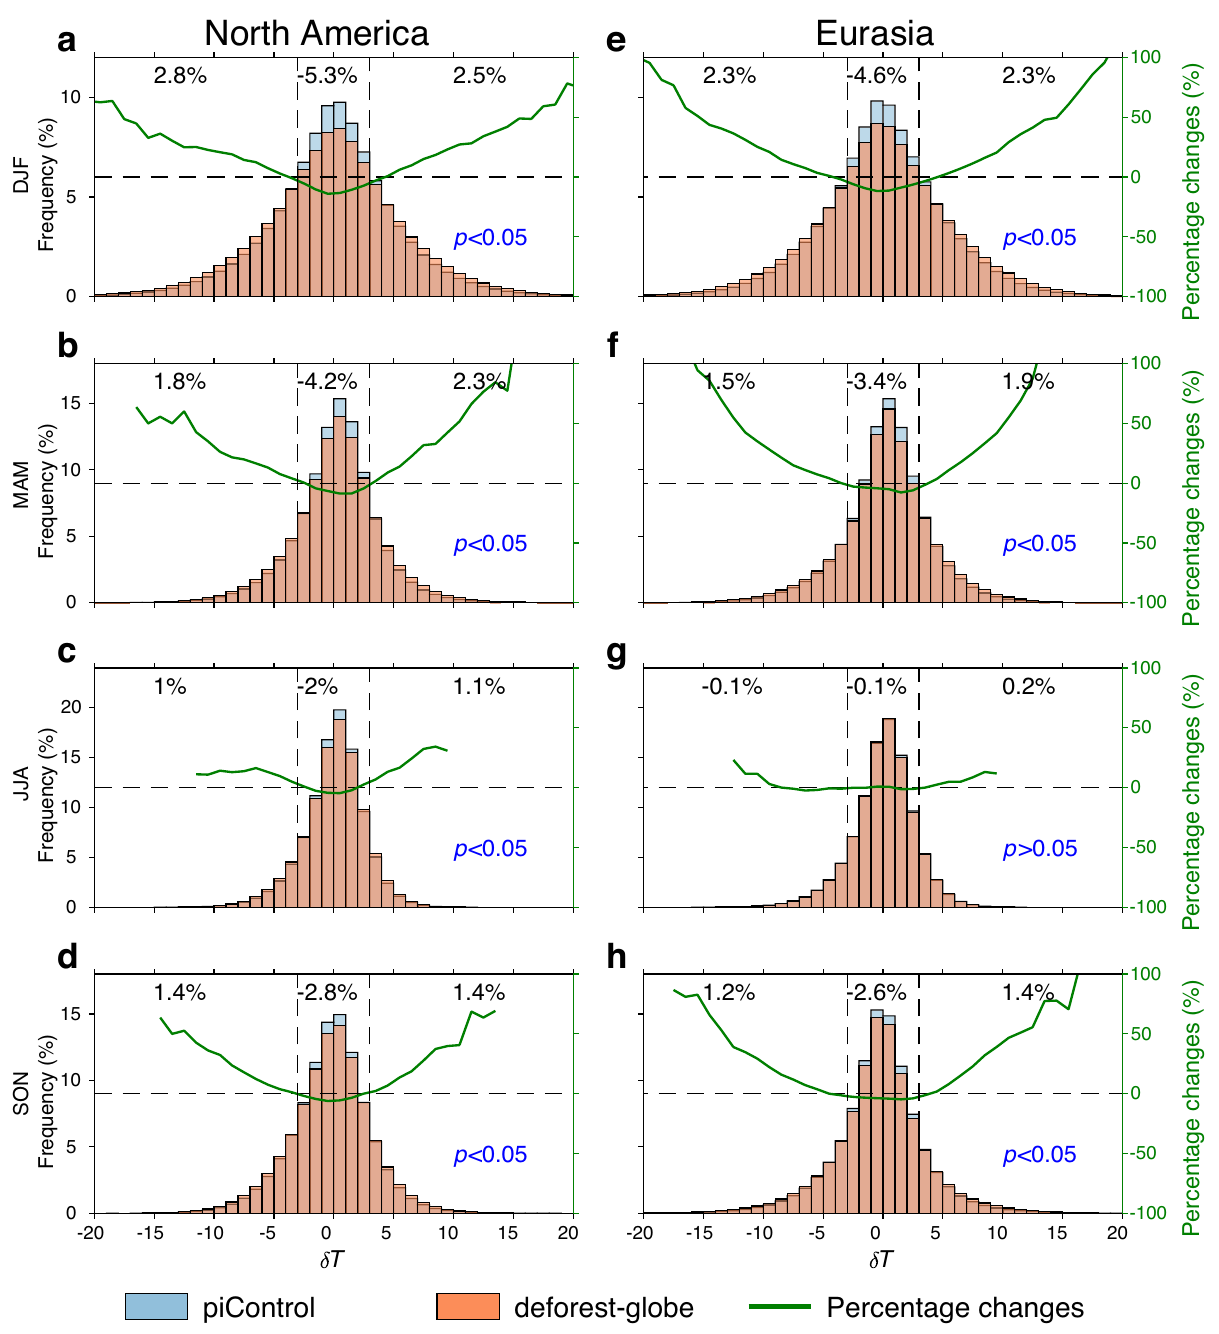
Fig. 2 | The deforestation effect on temperature differences between neigh- boringdays. Theprobabilitydensitydistributionoftemperaturedifferencesbetween neighboring days ( δ T ) for the piControl (blue bars) and deforest-globe (orange bars) simulationsinthedeforestedareasof a – d NorthAmericaand e – h Eurasia(denotedby theblackrectanglesinFig.1c)in a , e DJF(December,JanuaryandFebruary), b , f MAM (March, April and May), c , g JJA (June, July and August), and d , h SON (September, deforested areas in North America (38 – 54°N, 60 – 122°W) and Eurasia (52 – 66°N, 20 – 120°E; denoted by the black rectangles in Fig. 1c). Compared to the piControl simulation (blue bars), the frequency is lower for the near-zero region (e.g., − 3 °C < δ T < 3°C) and higher for the tail regions (e.g., δ T < − 3 °C or δ T >3 °C) for the deforest-globe simulation (orange bars). Meanwhile, the frequency changes for the left and right tail regions arealmostidentical. Taking North America as an example, the frequency for wintertime δ T within − 3 °C to 3 °C